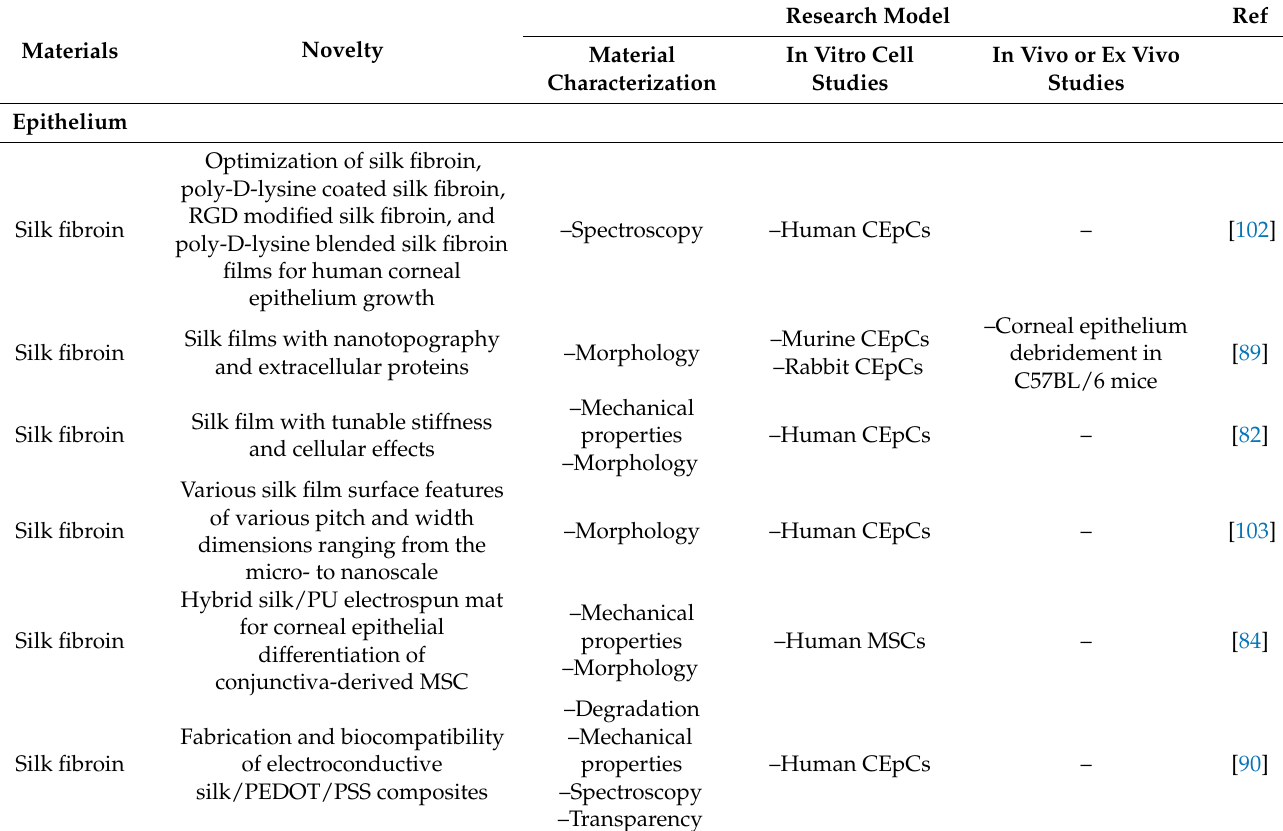
Table 3. Summary of current advances in natural scaffold and film engineering for corneal tissue.